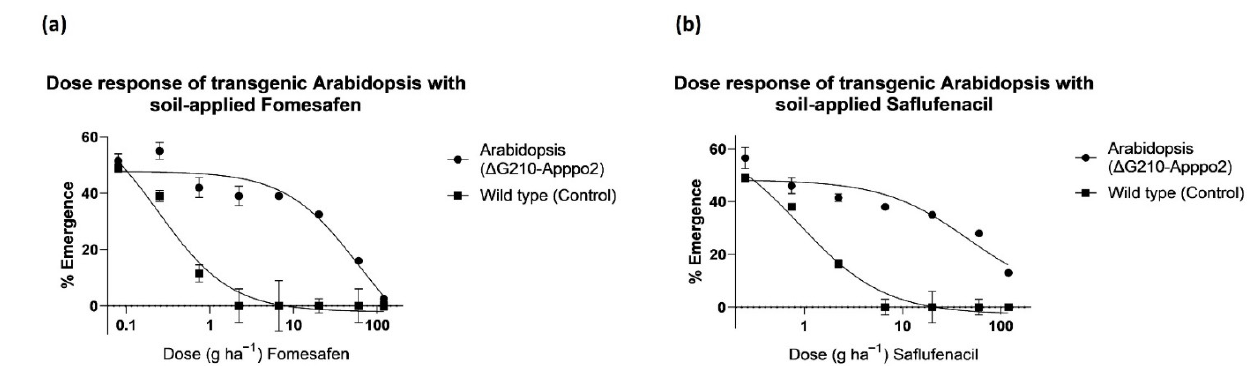
Figure 6. The dose–response curves for percentages of germinated transgenic ( ∆ G210-Apppo2 ) Arabidopsis. ( a ) Response to increasing doses of fomesafen and ( b ) saflufenacil.